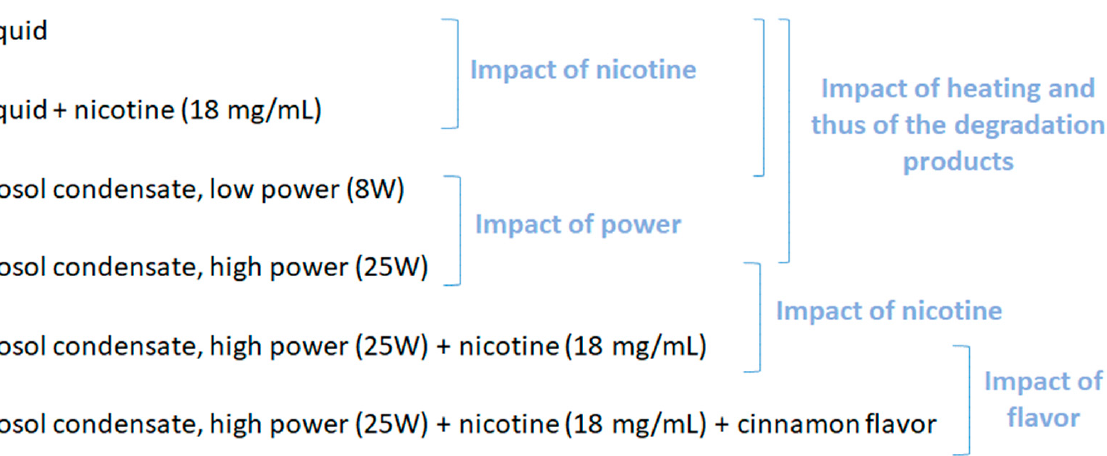
Figure 1. Definition of the experimental conditions used in this study and the comparisons that allowed determination of the impact of different parameters.